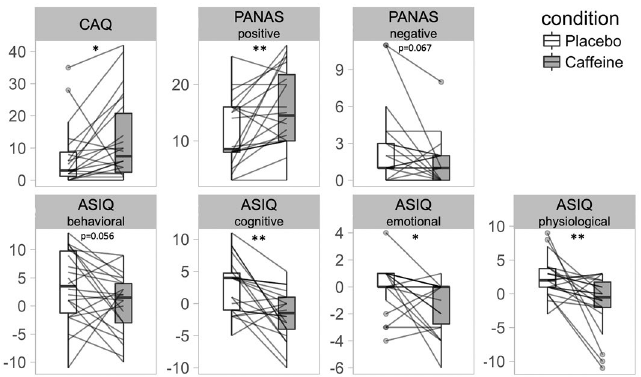
Figure 4. Post-awakening (7:15–8:00) assessments of subjective state. ASIQ = Acute Sleep Inertia Questionnaire (administered at 07:45). CAQ = Caffeine Acute Questionnaire. PANAS-positive = positive affective scale (administered at 07:15). PANAS-negative = negative affective scale (administered at 07:30). * p < 0.05; ** p < 0.01 (Benjamini–Hochberg